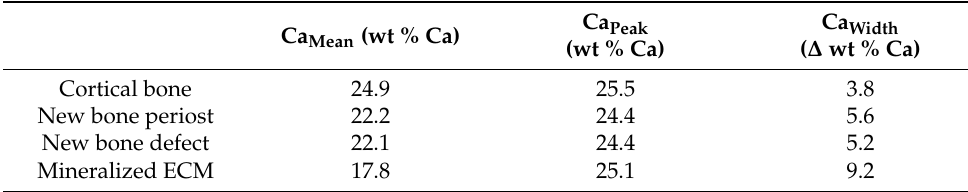
Figure 7. Quantitative backscattered electron imaging (qBEI) of one representative specimen. ( A ) The overview shows the regions of interest, which are prepicked, ( B ) in yellow for pre-existing cortical bone, ( C ) in red for new bone within the defect, and ( D ) in blue next to the periosteum, ( E ) in cyan the mineralized extracellular matrix with its scattered appearance of hypertrophic chondrocytes. The high magnification pictures correspond to these ROI showing the homogenous distribution of mineral in the pre-existing cortical bone, the various shades of grey in the immature new bone in the defect sites, originating from the periosteum and new bone observed inside the defect. Of particular interest is the heterogenous appearance of the mineralized extracellular matrix that closely resembles hypertrophic cartilage during development or upon fracture healing. ( F ) The bone mineral density-distribution obtained for the four different depicted ROIs; cortical bone (yellow) is higher mineralized than new bone (red and blue), and new bone in both investigated locations (within the defect and close to the periosteum) has a similar mineral distribution. In contrast, the scattered mineralized matrix with hypertrophic chondrocytes shows a very heterogenous mineral distribution (cyan). Scale bars: 1 mm ( A ) and 150 μm ( B – E have the same magnification).